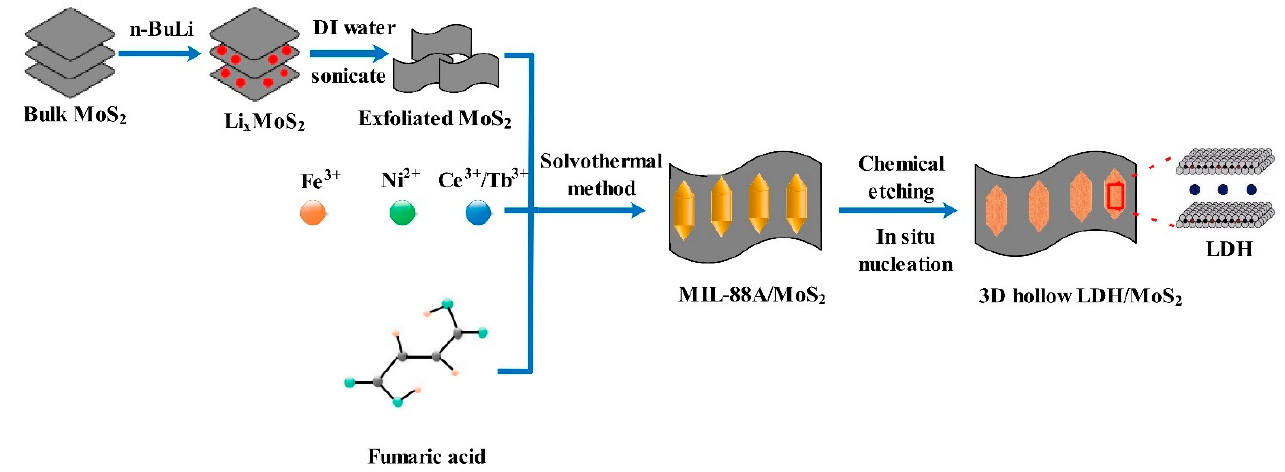
Figure 1. Schematic Diagram of 3D hollow LDH/MoS 2